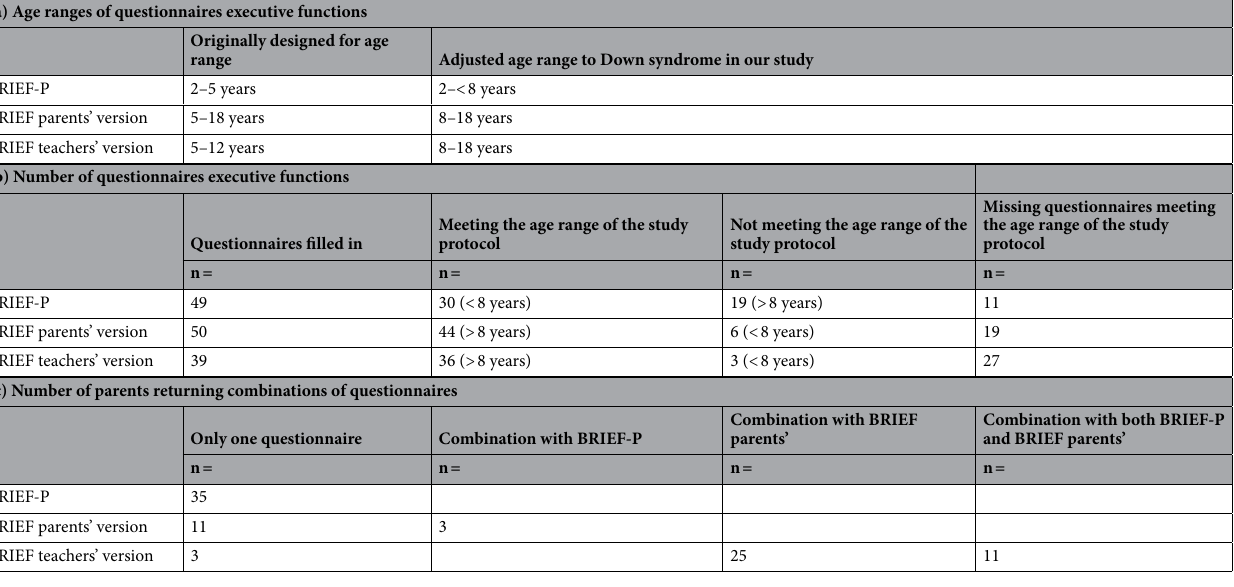
Table 3. Questionnaire return. Age ranges and numbers of filled BRIEF-P and BRIEF questionnaires. (a) The age ranges for which the questionnaires were originally designed as well as the adjusted age ranges used of children with DS in the current study. (b) The number of filled in questionnaires. (c) The number of combinations of questionnaires BRIEF-P, BRIEF parents’version and BRIEF teachers’version) which were returned by the parents. n = number of